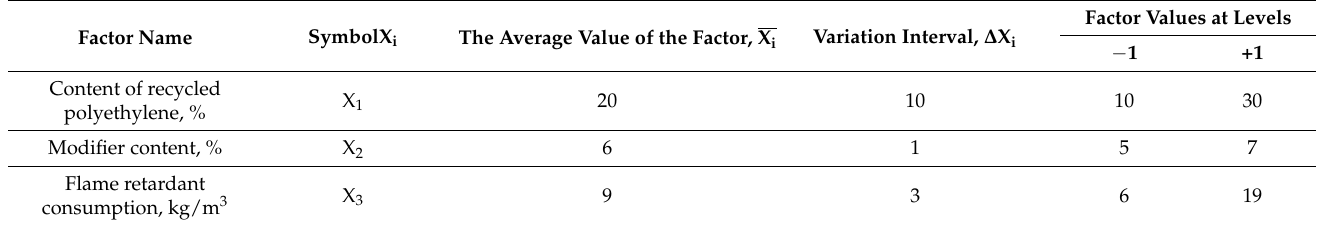
Table 1. Experimental